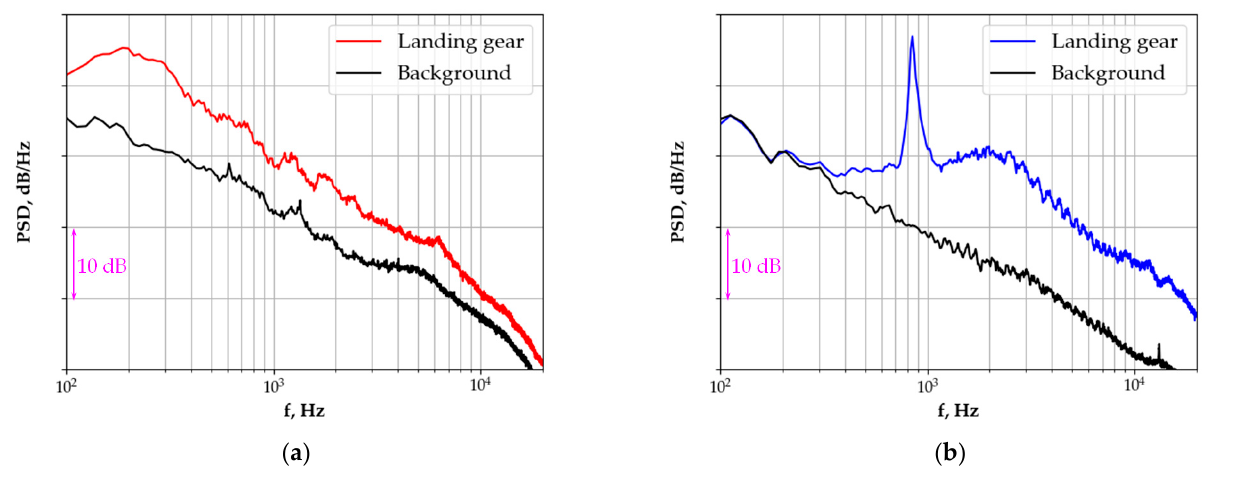
Figure 9. Noise spectra for the background noise and noise of the four-wheel landing gear model at flow velocity 75 m s − 1 ; microphone is located at ( θ , φ ) = (90°, 20°): ( a ) Full-scale model in FL-17; ( b ) Small-scale model in AC-2 TsAGI.